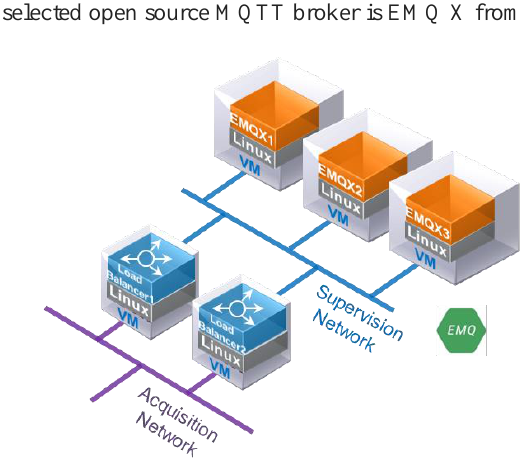
Fig. 4. CAREDAS MQTT